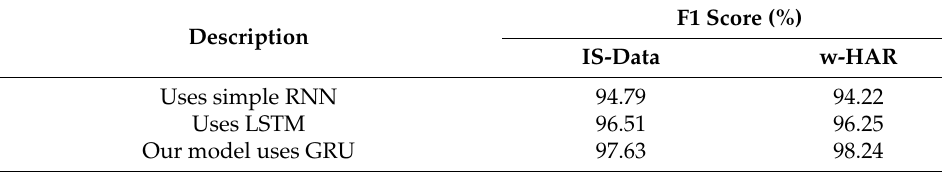
Table 9. Impact of